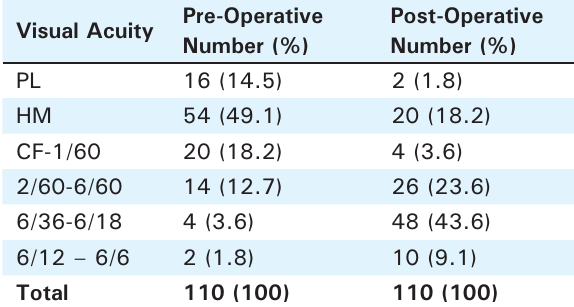
Figure 1. Distribution of myopia Total 34.55% (n=38) of patients with retinal detachment were myopic (Figure 1). Among them,